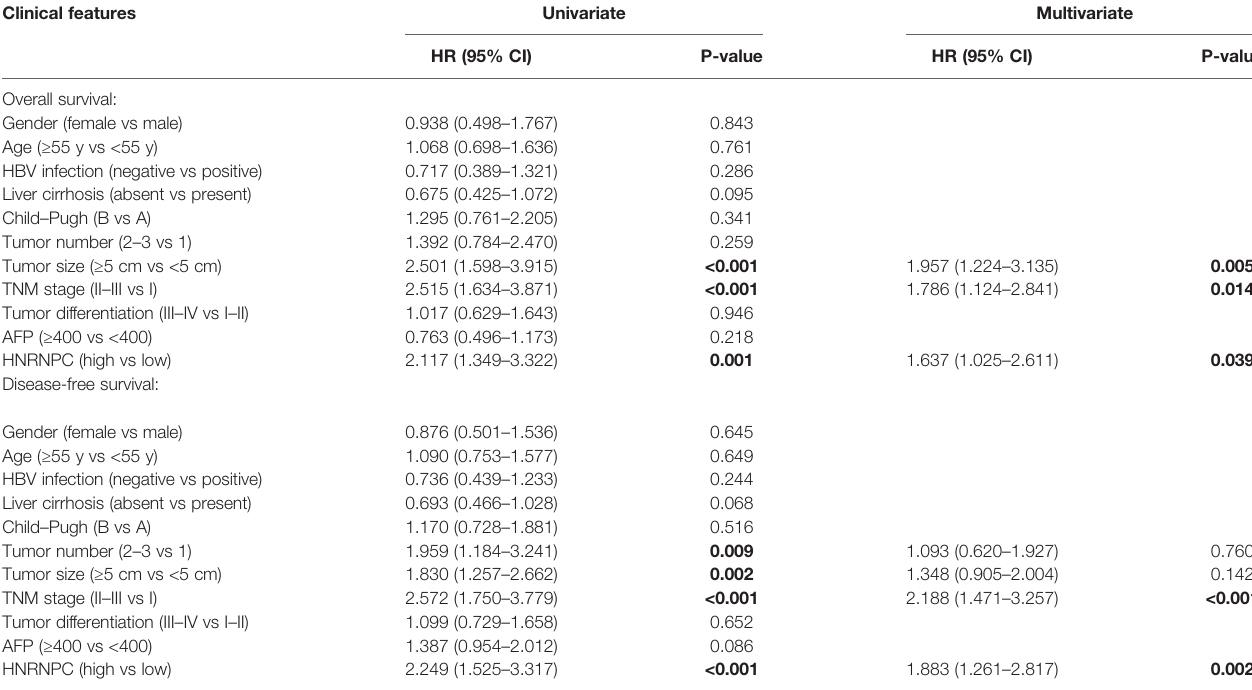
TABLE 2 | Univariate and multivariate analysis for survival of 147 HCC